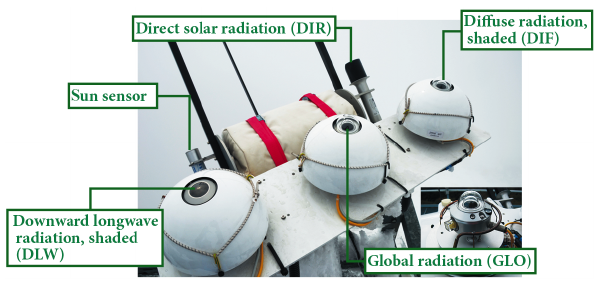
Figure 2. Typical ARAD station: suntracker with different radiation sensors. The picture in the lower right corner shows a pyranometer without radiation shield exposing the heating and ventilation system